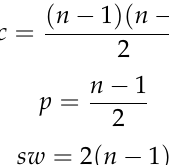
Figure 3. FBDC Topology.